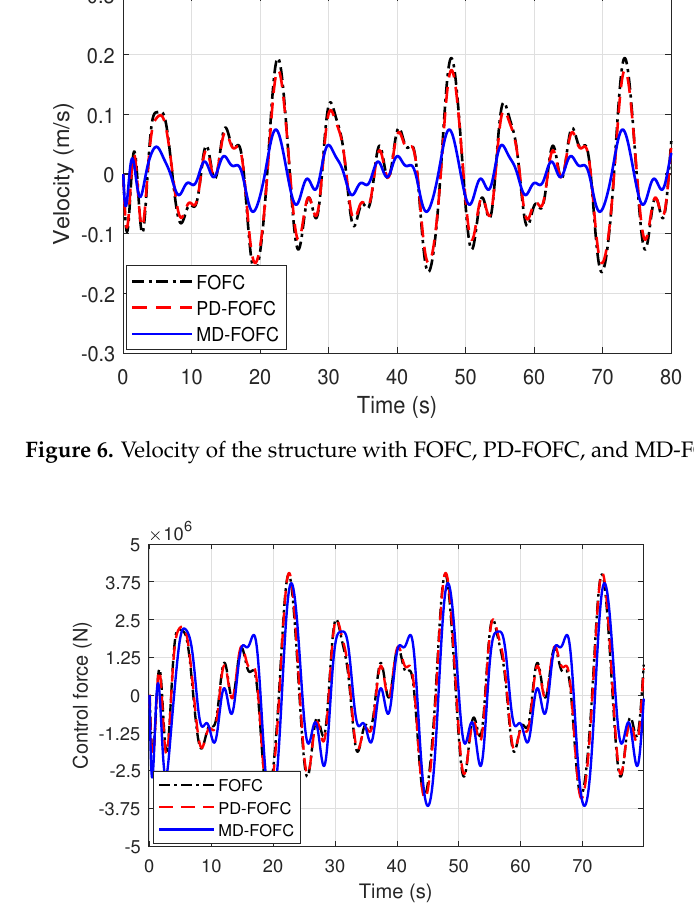
Figure 7. Control force by FOFC, PD-FOFC, and